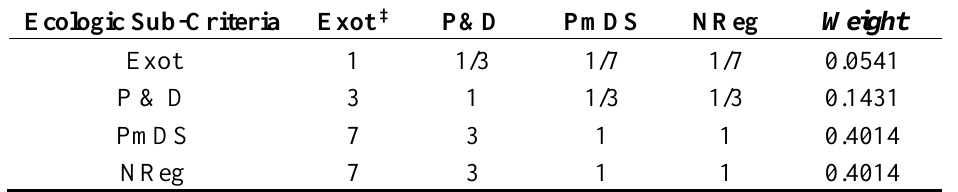
Table 5. Pairwise comparison matrix and relative weights of ecological sub-criteria to estimate the level of risk of the Pseudotsuga menziesii populations’ in central Mexico †